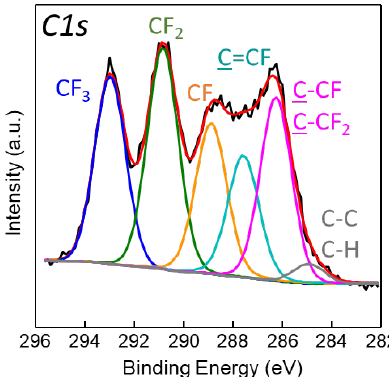
Figure 2. XPS C1s high-resolution spectrum of the plasma-polymerized